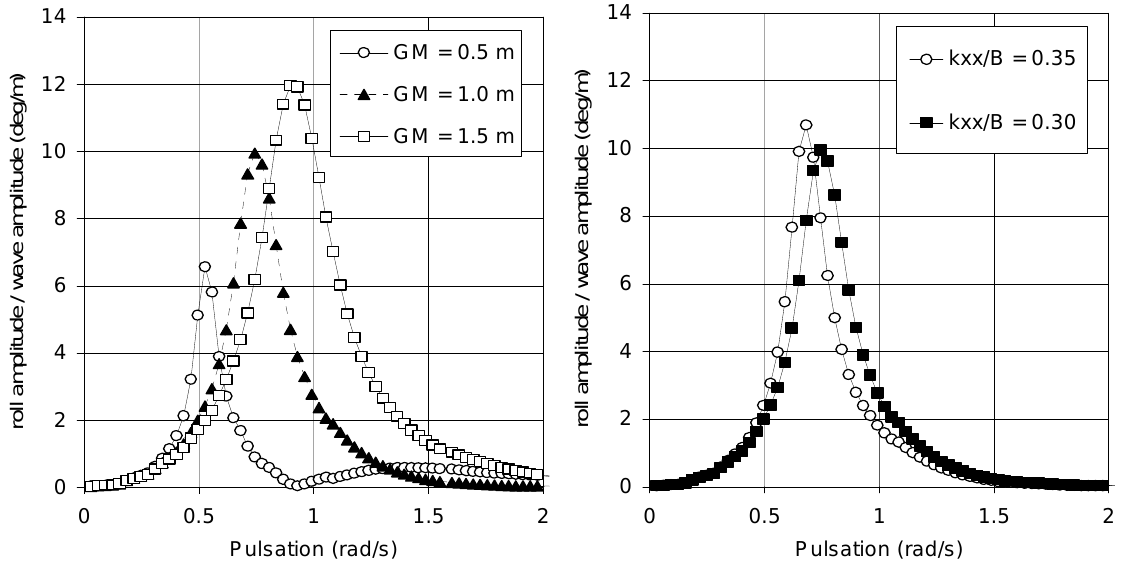
Figure 9. Estuary tanker: effect of loading condition parameters on roll response amplitude operator. Figure 9a (left): effect of metacentric height (GM). Figure 9b (right): effect of radius of inertia along longitudinal axis (k xx